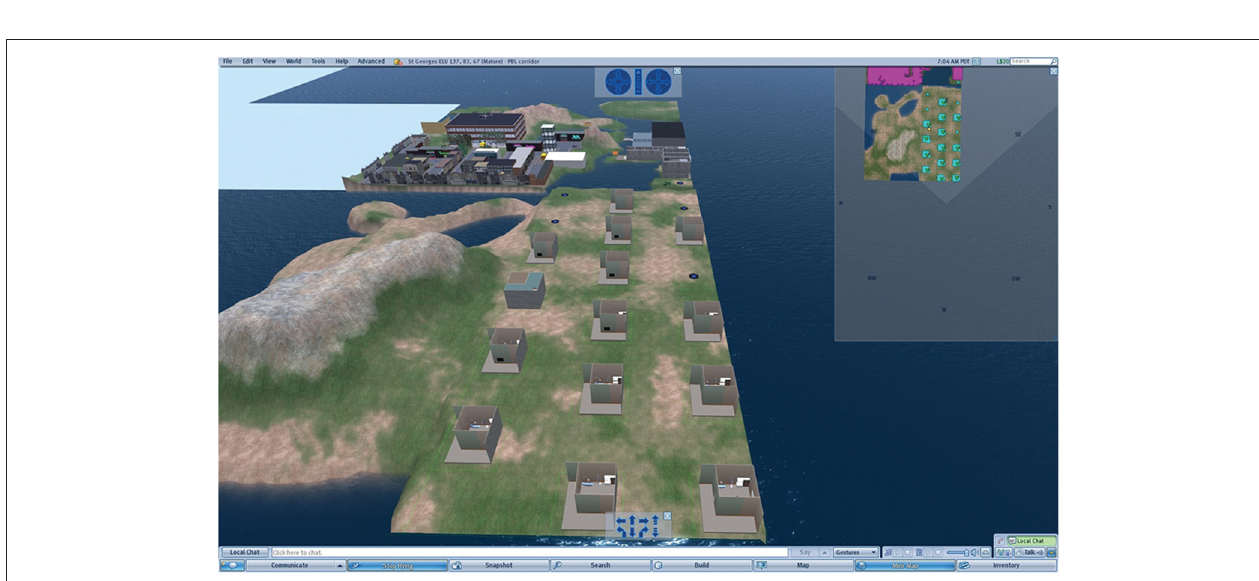
FIGURE 4 | Once the case was launched, the 3-dimensional room, in this case the Renal Unit, would appear around the avatar.